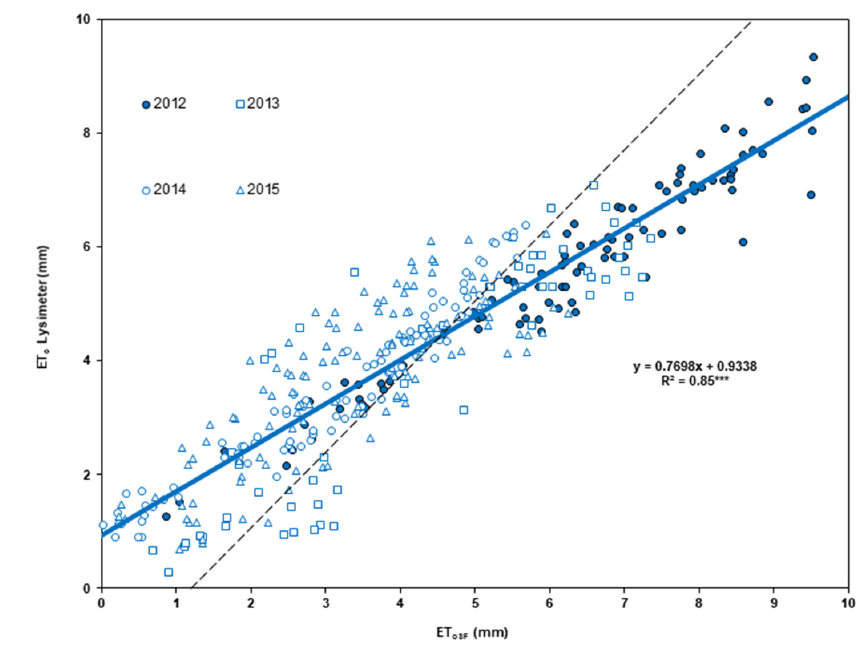
Figure 7. Relationship between crop evapotranspiration obtained with sap flow sensors (ET cSF ) and crop evapotranspiration obtained by weighing lysimeter (ET cLys ) along the crop season corresponding to the years 2012, 2013, 2014 and 2015, under irrigated conditions. The relationship was fitted to a simple linear model n = 378. *** indicates that the factor was significant at p < 0.001.